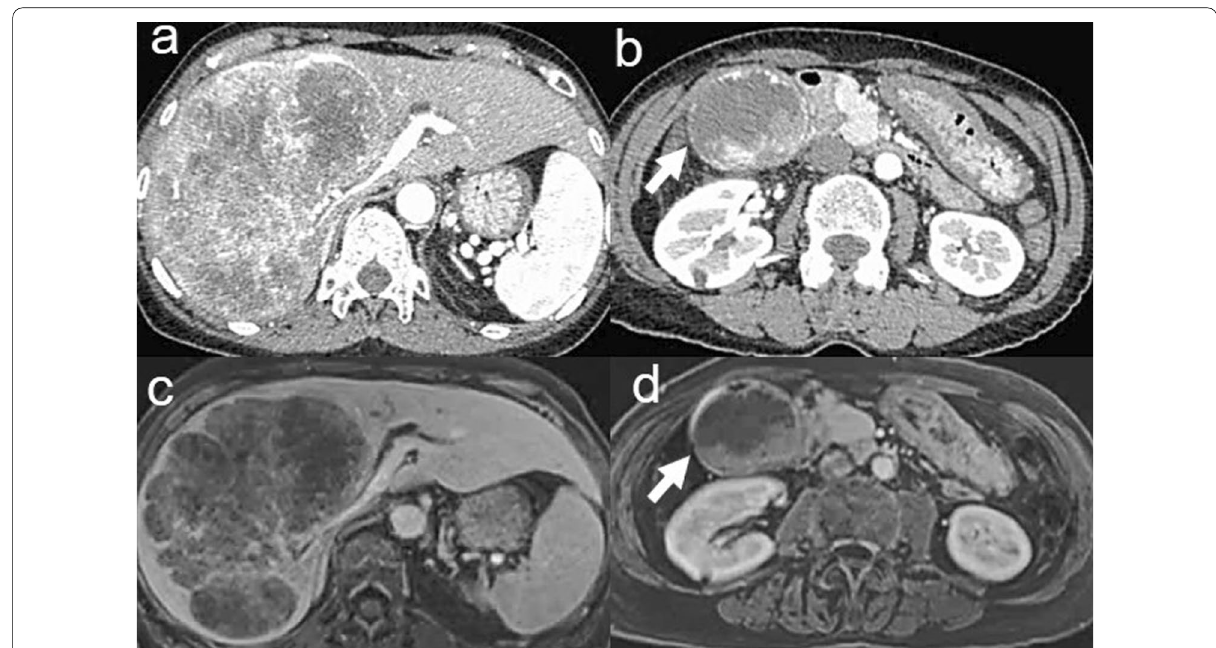
Fig. 1 a Dynamic computed tomography (CT) shows a tumor measuring 12 tumor is found in the gallbladder. c Contrast-enhanced magnetic resonance imaging (MRI) demonstrated the liver tumor. d The gallbladder tumor is also detected as an enhanced mass arrow